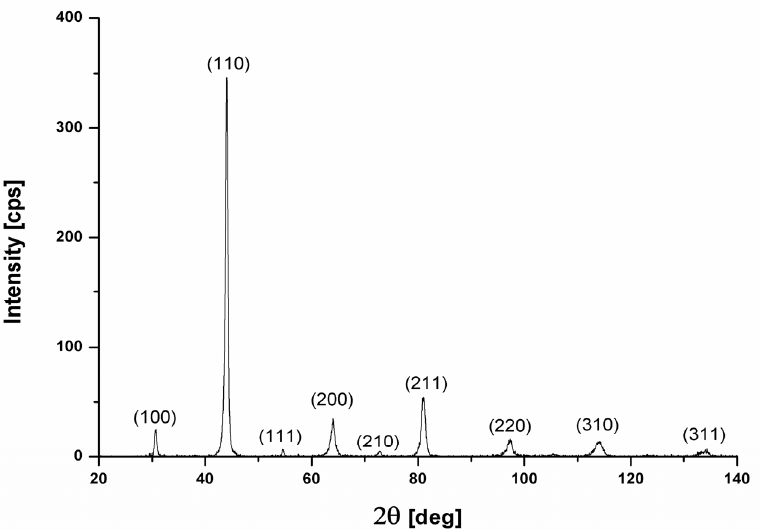
Figure 1. An example of diffraction pattern taken from of the sinter after the full cycle of heat treatment.